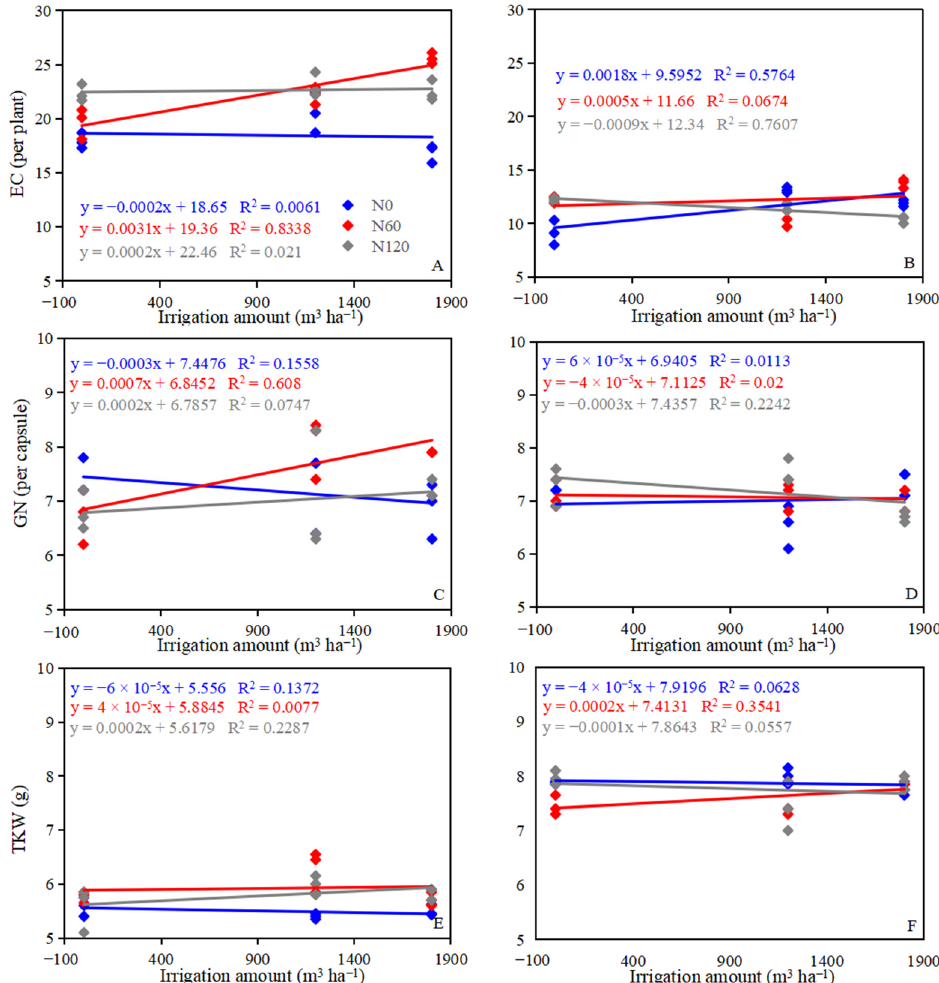
Figure 5. The yield component response to irrigation amount in the 2017 ( A , C , E ) and 2018 ( B , D , F ). A and B, EC, effective capsule number; GN, grain number; TKW, thousand kernel weight. Over the two growing seasons, a positive relationship was observed between GY and EC (Figure 6A). There was a positive relationship between GY and GN, TKW in 2017 (Figure 6B,C), but a negative relationship existed between GY and GN, TKW in 2018 (Figure 6B,C), which indicates that the increased GY was due to the higher EC in this study.